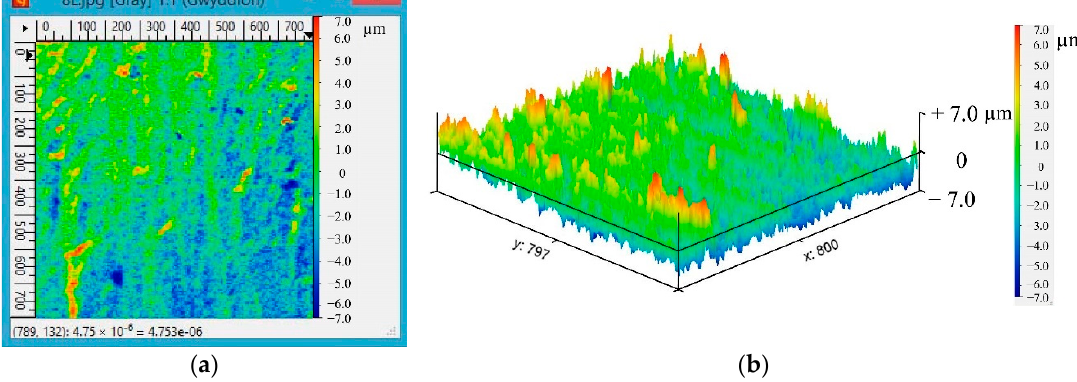
Figure 11. Surface area treated with LCLr: 2D ( a ) and 3D ( b ) images of the surface.